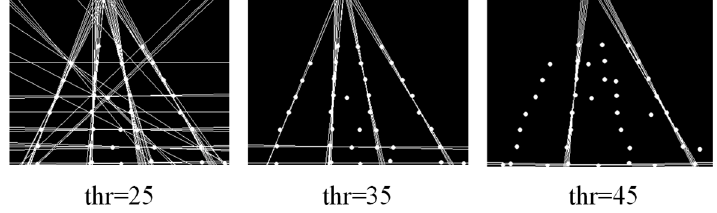
Figure 17. Hough transform at different accumulated